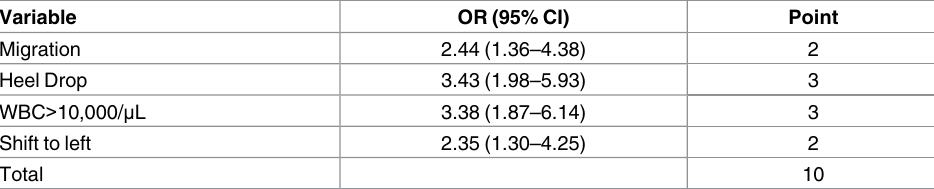
Table 3. Development of the MESH score.